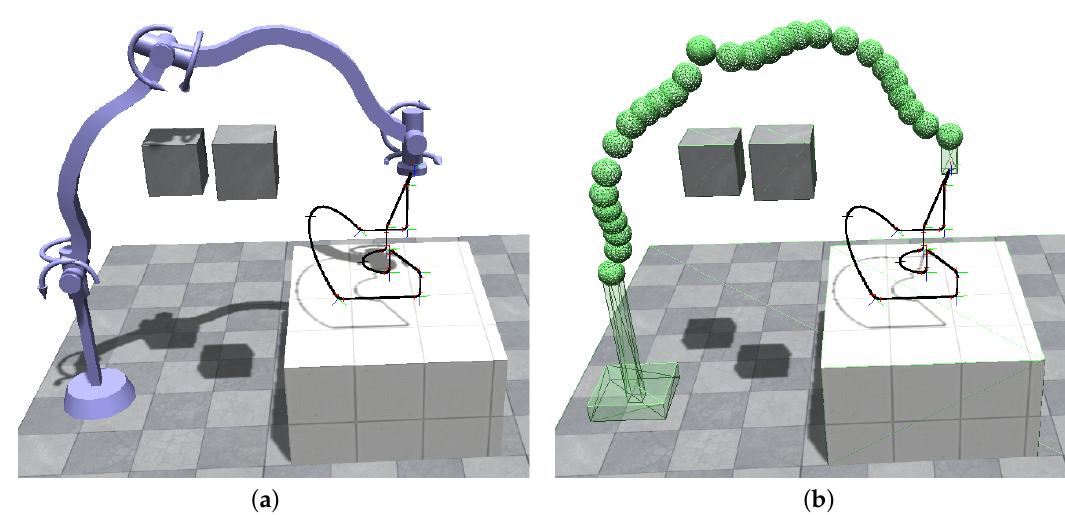
Figure 5. Example of a simple workplace and a robot with the selected kinematic structure, where both the lower and upper arms bend according to the cubic Bézier curve. ( a ) Schematic model of the robot. ( b ) Visualization of collision bounding